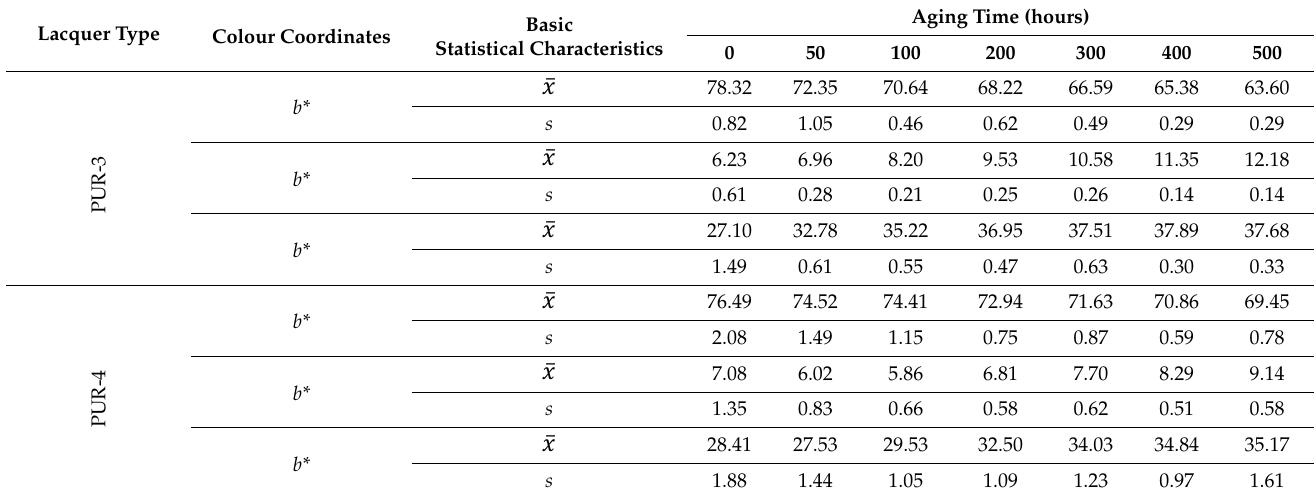
Table 3. Basic statistical characteristics of colour coordinates L * , a * , and b * corresponding to different phases of the accelerated aging process of spruce wood surface-treated with polyurethane lacquers. (The number of measurements for each set n = 50.)